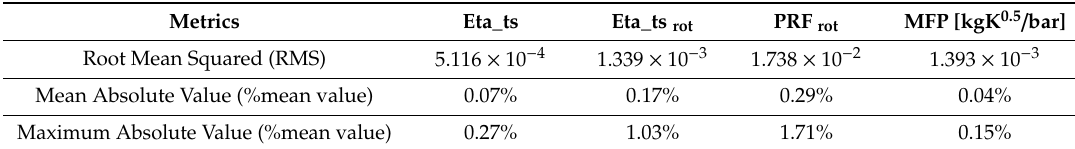
Table 5. Metrics for Leave-one-out cross validation (PRESS) of the response